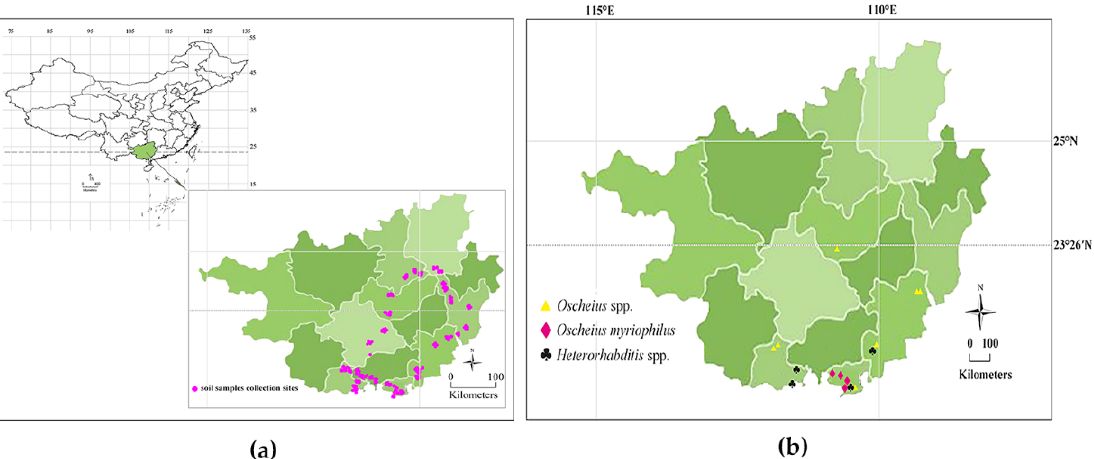
Figure 1. Distribution map of soil samples and entomopathogenic nematodes collected in Guangxi, China: ( a ) soil sample collection sites; ( b ) entomopathogenic nematodes.